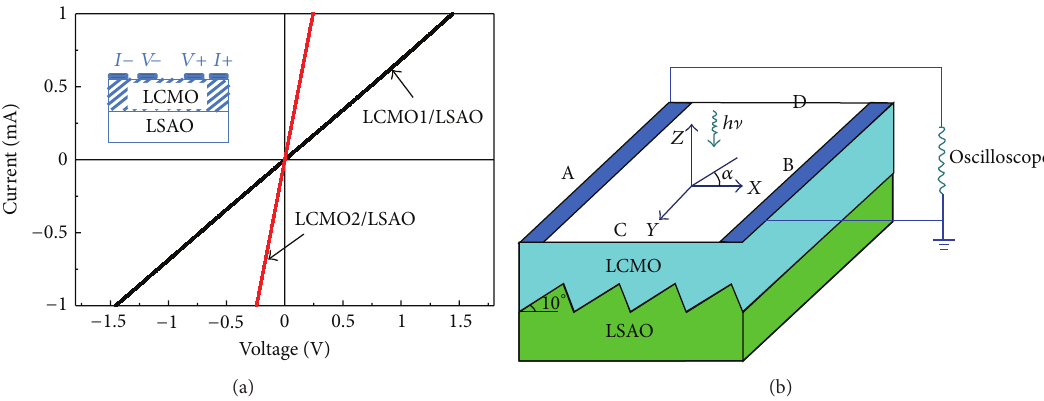
Figure 2: (a) 𝐼 - 𝑉 characteristics of the LCMO1 and LCMO2 films along tilted directions (AB) at room temperature. (b) Schematic illustration of the samples, electrodes structure, and the circuit of the measurements. Electrodes A and B are along the tilted direction ( 𝑥 is the “tilted direction” of the film) and electrodes C and D are along the untilted direction ( 𝑦 is the “untilted direction” of the film).